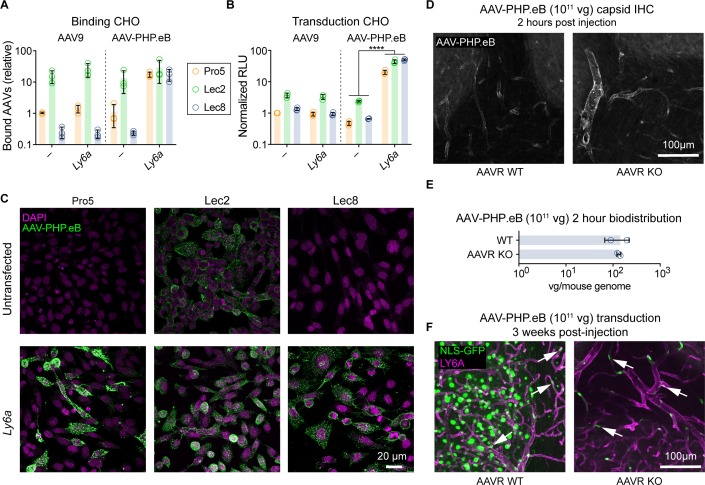
Ly6a expression renders cells permissive to AAV-PHP.eB transduction in the absence of galactose or AAVR.(A-C) AAV-PHP.eB or AAV9 viruses were added to control Pro5 CHO cells, Lec2 CHO cells with excess galactose, or Lec8 CHO cells deficient for galactose transfer. (A) Quantification of AAV binding to CHO cell derivatives via qPCR for viral genomes. (B) Transduction of CHO cells as measured by Luciferase assay 48 hours after virus addition, normalized to values from Pro5 cells transduced with AAV9. (C) AAV-PHP.eB capsid immunostaining of CHO cells that were untransfected (top row) or transfected with Ly6a (bottom row). (D-F) WT or AAVR KO mice were intravenously injected with AAV-PHP.eB:CAG-NLS-GFP (1011 vg/mouse) and brain tissue was assessed via IHC for capsid binding (D), vector genome biodistribution analysis (E) at two hours, or transduction (F) at three weeks post-injection (D-F: n = 2 per group/per experiment, mean ± SD). (F) Representative images of GFP fluorescence (green) with LY6A IHC (magenta).